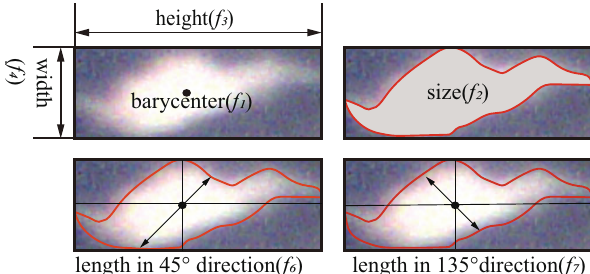
Figure 3. Illustration of each